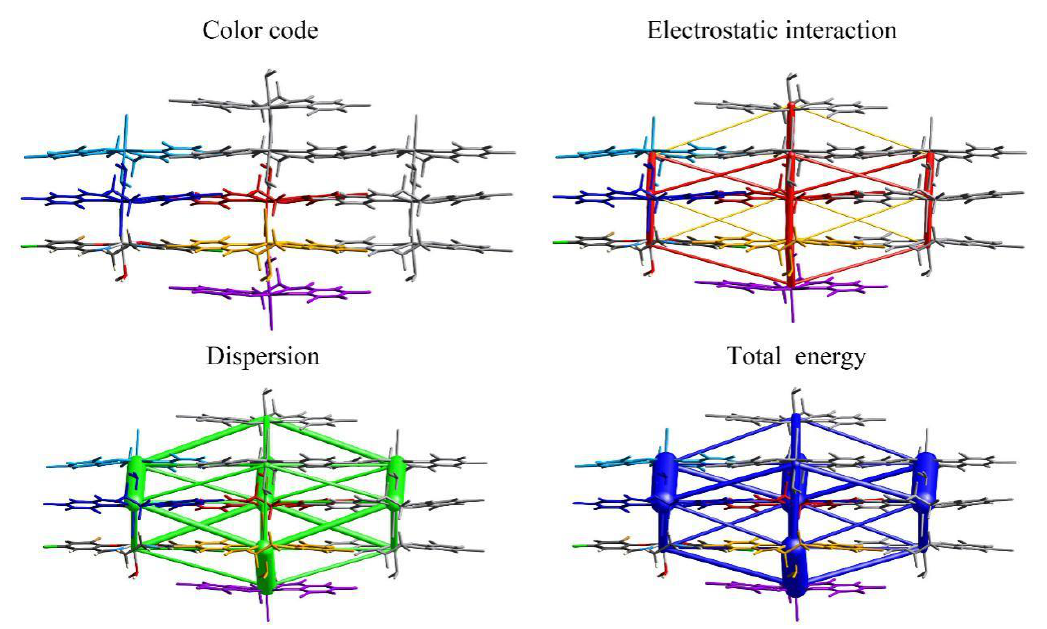
Figure 10. Visualization of the intermolecular interaction energy: red for Coulomb, green for dispersion, and blue for total interaction energies of the title structure along a axis.